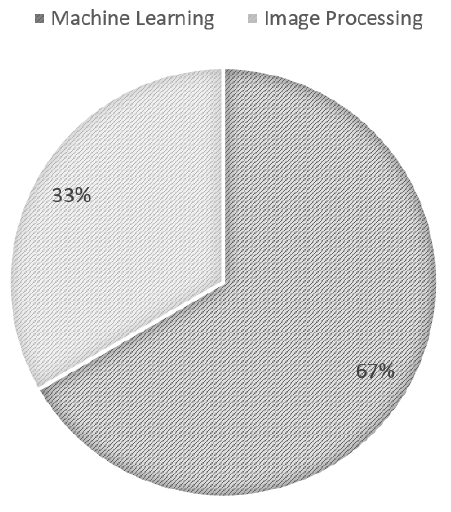
Figure 6. Distribution of articles among machine learning and image processing domains for crack detection.